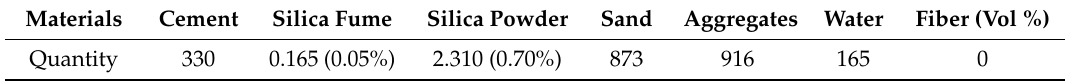
Table 1. Concrete mix details (kg / m 3